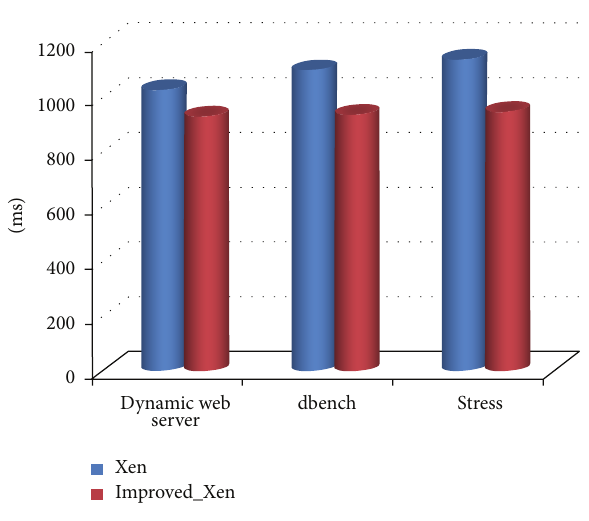
Figure 8: Downtime for advanced workloads. Table 2: Accuracy comparison of different